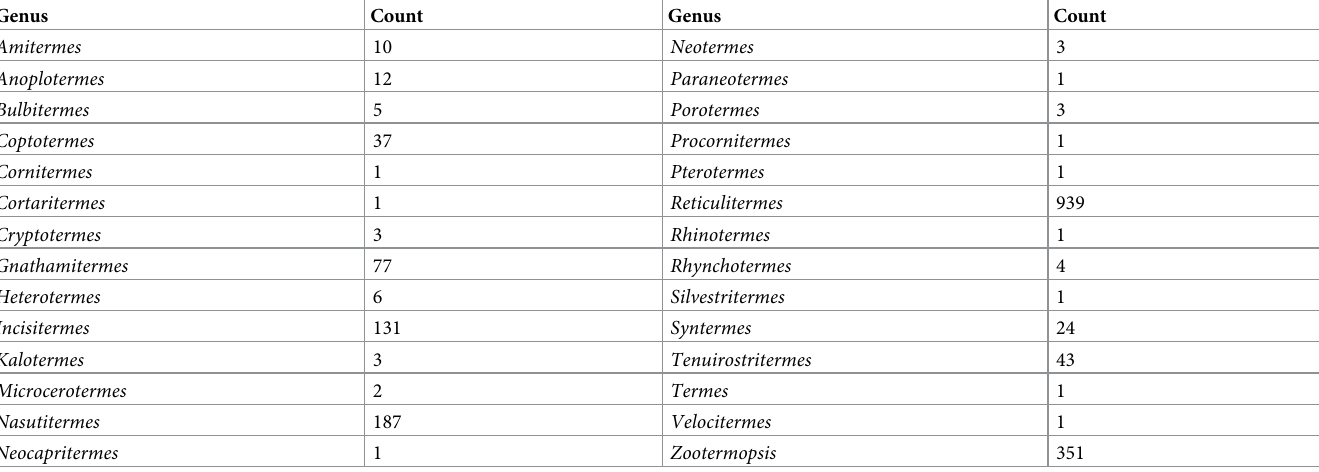
Table 2. Termite genera of analyzed iNaturalist records for the